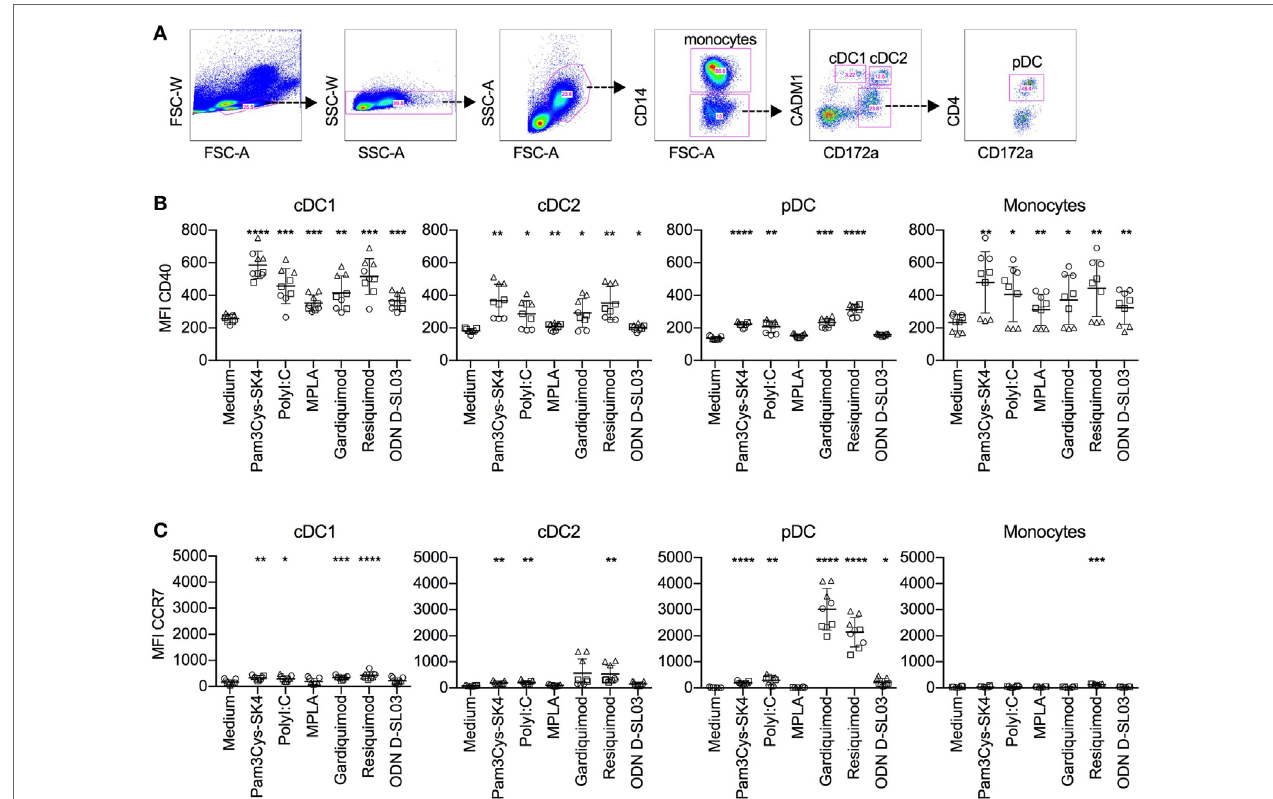
FigUre 7 | Activation marker response of DC subsets after stimulation with toll-like receptor (TLR) ligands. Peripheral blood mononuclear cells were cultured with TLR ligands for 5 h, and activation marker expression on mononuclear subsets was determined using five-color flow cytometry. (a) Gating strategy for identifying conventional DC1 (cDC1), cDC2, and plasmacytoid dendritic cell (pDC) subsets. After doublet exclusion and forward/side scatter gating on large cells, monocytes were identified as CD14 + cells, cDC1 as CD14 − CD172a low CADM1 + , cDC2 as CD14 − CD172a high CADM + , and pDC as CD14 − CD172 + CD4 + . (B) CD40 levels. (c) CCR7 levels on mononuclear cell subsets. The figure shows biological replicates of three independent experiments. Statistical significance was calculated using ANOVA followed by Tukey’s test (**** P < 0.0001; *** P < 0.001; ** P < 0.01; * P <